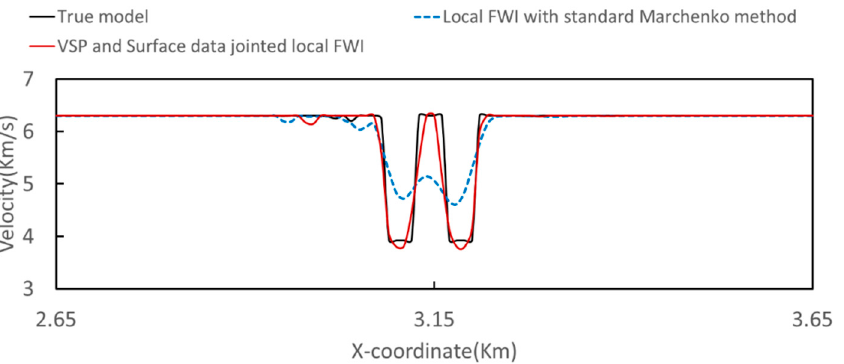
Figure 11. Comparison of velocity lateral profile from true model and inverted models using differ- ent methods.